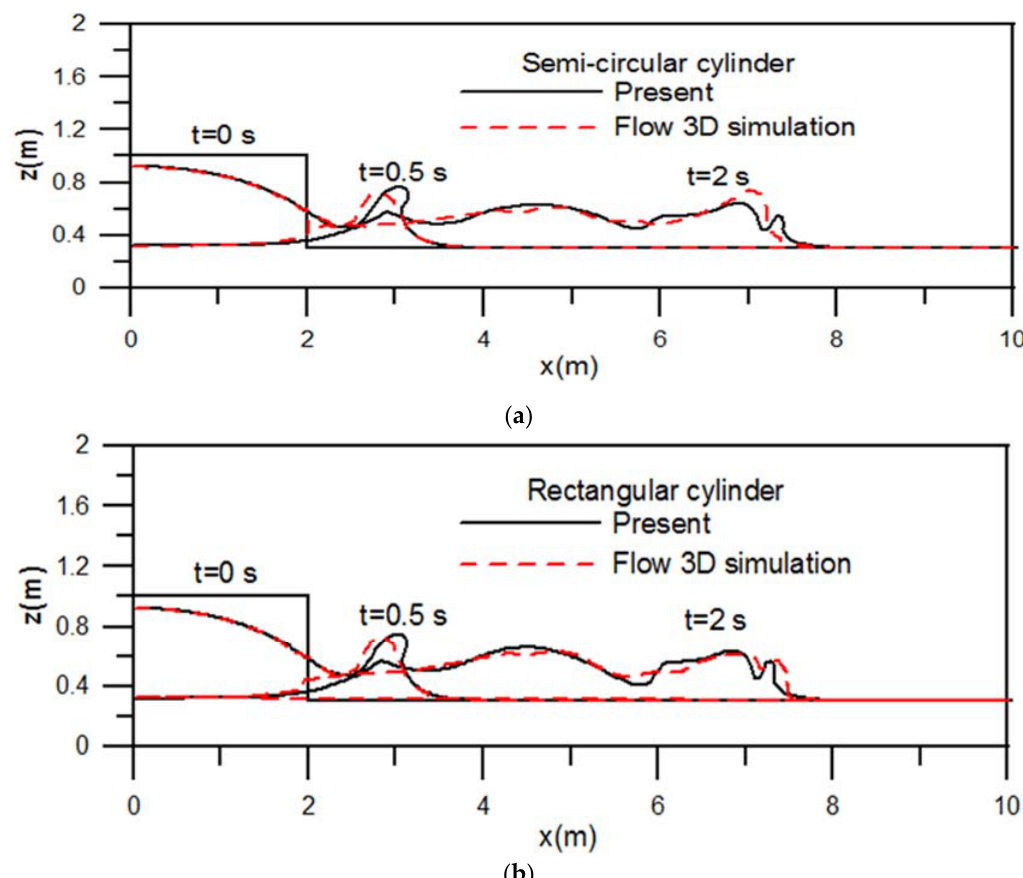
Figure 14. Comparisons of free-surface elevation at t = 0.5 s and t = 2.0 s: ( a ) semicircular cylinder and ( b ) rectangular cylinder.